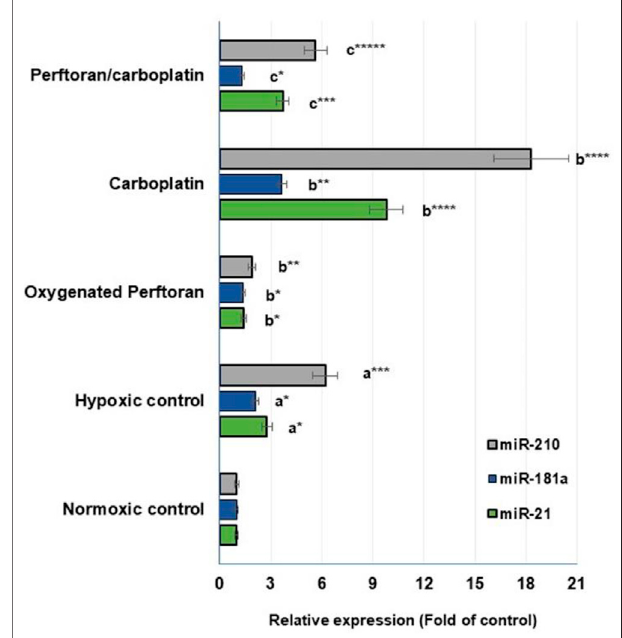
FIGURE 3 | Expression of hypoxamiRs (miR-21, miR-181a, and miR- 210): Relative expression of miRNAs in lung A549 cells was estimated via qRT-PCR.Resultsareexpressedasfoldofthecontrolnormoxiccells.Results were compared to a normoxic cells, b hypoxic cells, and c carboplatin- treated cells; * p < 0.05, ** p < 0.01, *** p < 0.001, and **** p <